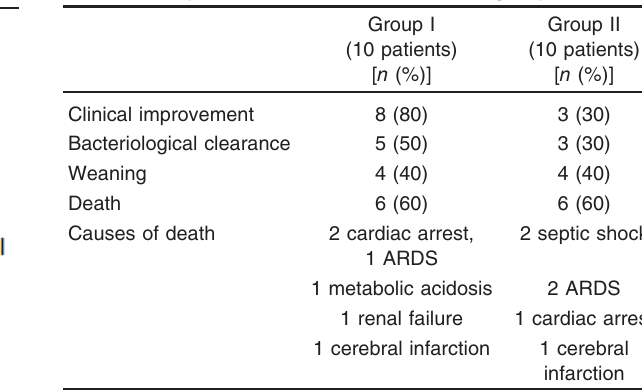
Table 8 Comparison of outcomes in the two